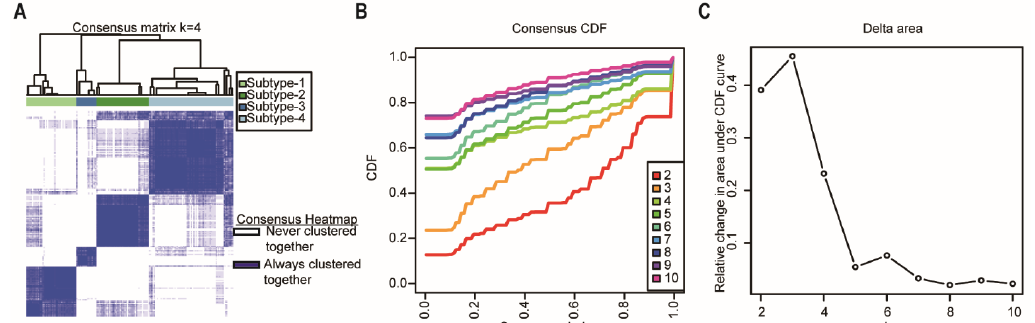
Figure 3. Identification of network-based subtypes by unsupervised consensus clustering. ( A ) Con- sensus matrix heatmap of 176 TCGA pancreatic cancer samples when k = 4. The rows and columns represent patient samples, and consensus matrix values vary from 0 in white (indicating that patients are never clustered together) to 1 in dark blue (indicating that patients are always clustered together). ( B ) Consensus CDF shows a real random variable of its probability distribution based on consensus scores for different subtype numbers (k = 2–10). ( C ) The delta area plot for k changed from 2 to 10. The vertical axis is the relative change in the area under the CDF curves when the cluster number varies from k to k + 1. The range of k changed from 2 to 10. Abbreviations: CDF, cumulative distribution function; TCGA, The Cancer Genome Atlas.